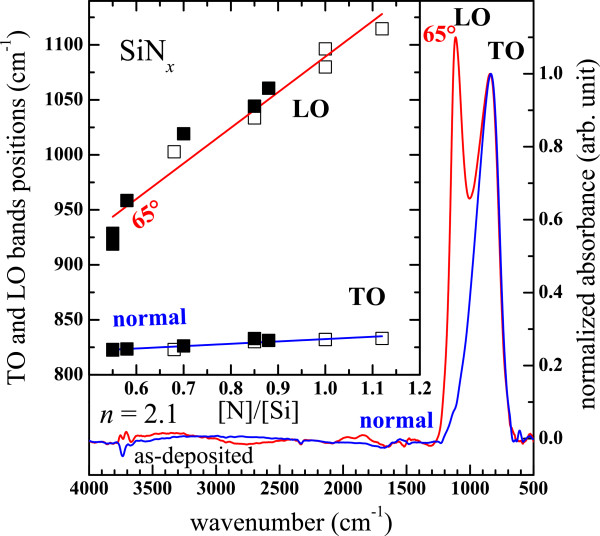
FTIR spectra of a SiNxthin film. The films were deposited by the N2-reactive method recorded with a normal incidence and with an incidence angle of 65°. The inset shows the TO and LO band positions of SiNx layers deposited by the N2-reactive (full squares) and the co-sputtering (empty squares) methods as a function of the composition.